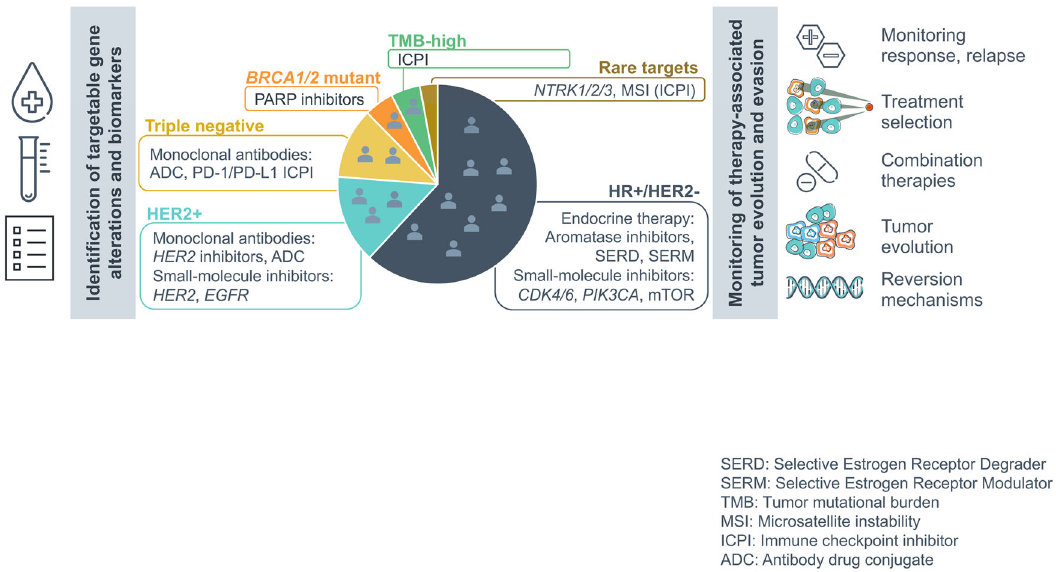
Fig. 1 | Graphicaloutlineoftargetedtherapiesin breast cancer and theclinical utility of liquid biopsy pro fi ling during the course of care. Liquid biopsies may be utilized in identifying targetable gene alterations and biomarkers for speci fi c therapies across different subtypes of breast cancer as well as in monitoring